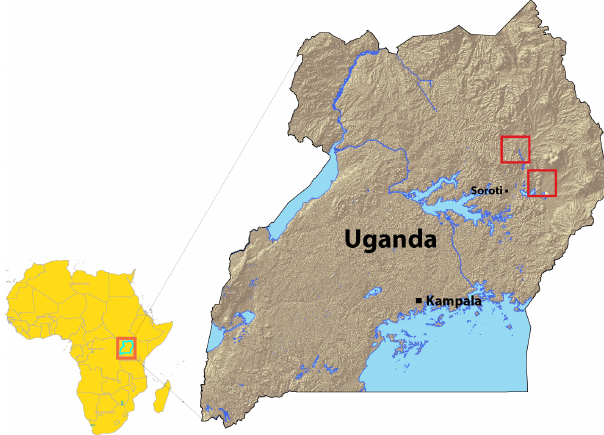
Figure 1. Map of Uganda; Kapelebyong and the gauge are marked by the top red square, and Magoro and Ngariam are located at the bottom red